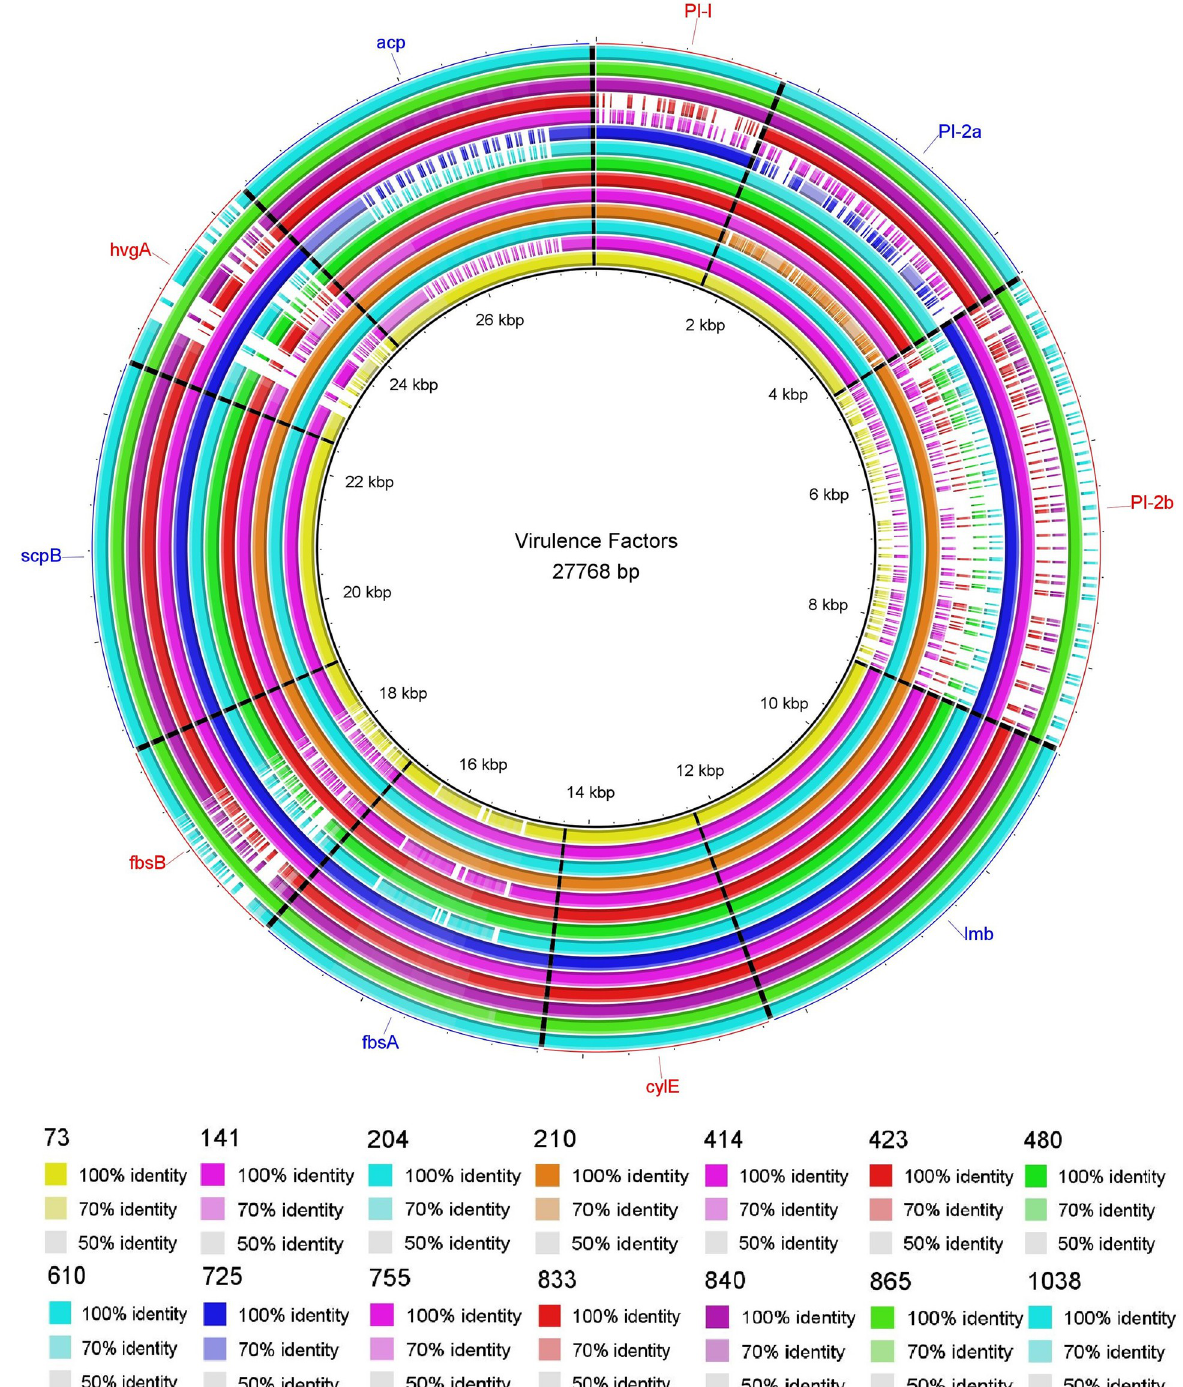
Fig 2. Localization in a circular map of scpB , lmb , fbsA , fbsB , acp , hvgA , Pili (PI-1, PI-2a and PI-2b), and cylE identified in 14 GBS isolates. Mapping was made by comparative sequence alignment using the BRIG program. Comparative BLASTn analysis with 70, 90 and 100% identities are displayed and gaps in circles represent regions with no identity of